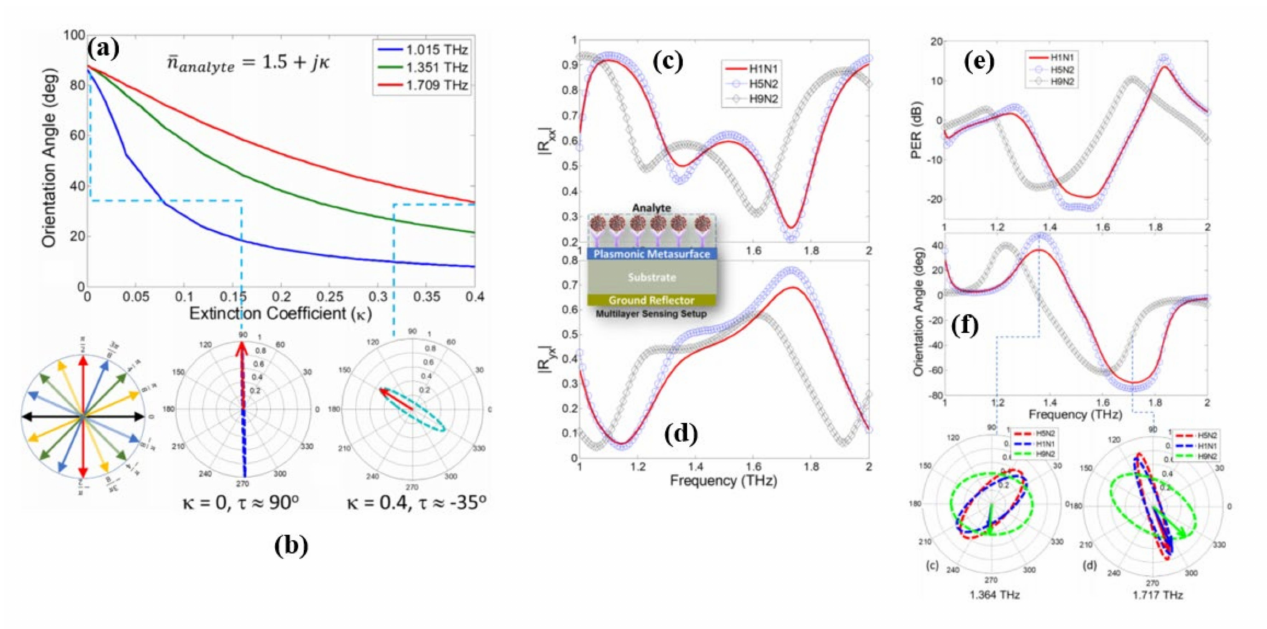
Figure 10. ( a ) Changes in orientation angle as κ is increased from 0 to 0.4 calculated at the frequencies where dominant power is reflected as cross-polarized fields. ( b ) contour path traversed by locus tip of electric field vector in time at fixed frequency of 1.7 THz for κ = 0 0 and κ = 0.4. ( b ) Magnitude response of (i) co-polarized (ii) cross-polarized reflection coefficients of the sensor for three different strains of Influenza viruses H1N1, H5N2 and H9N2. ( c ) PER and ( d ) Orientation angle spectrum for three different strains of influenza viruses H1N1, H5N2 and H9N2. The contour path traversed by locus tip of electric field vector in time at fixed frequency of ( e ) 1.364 THz and ( f ) 1.717 THz for all three strains of viruses. Reprinted with permission from [66]. Copyright 2021